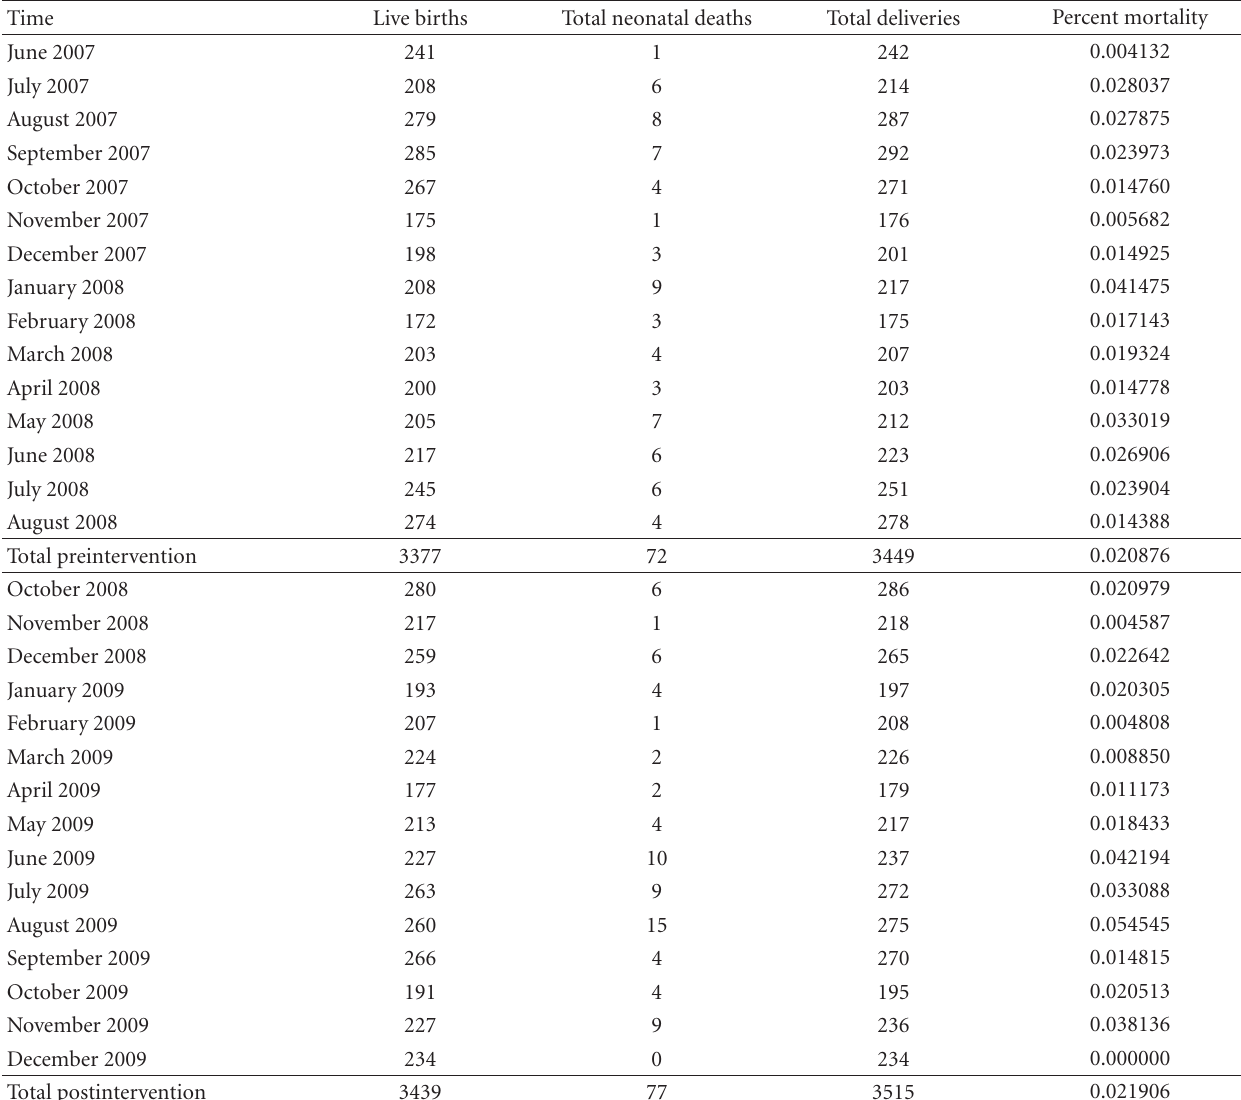
Table 4: Pre- versus postintervention neonatal mortality